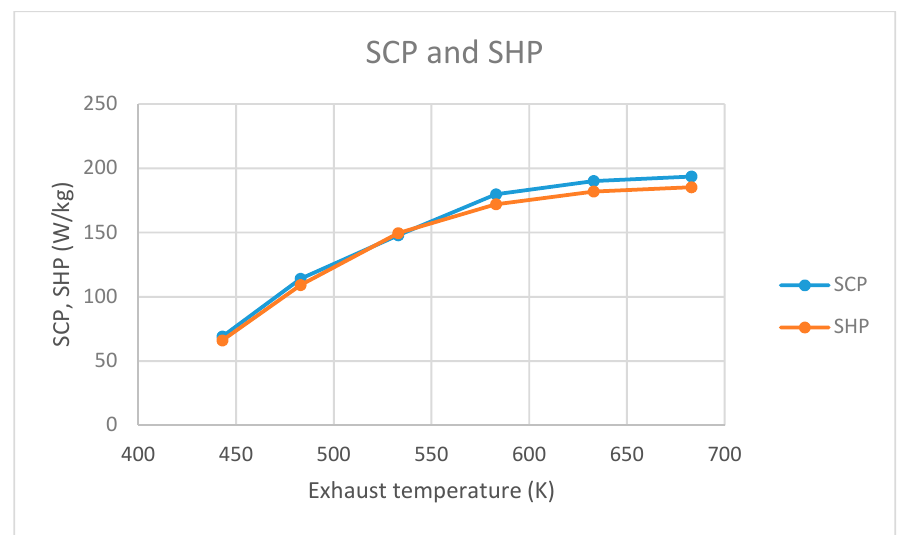
Figure 9. Specific cooling power (SCP) and specific heating power (SHP) versus exhaust tempera- ture.